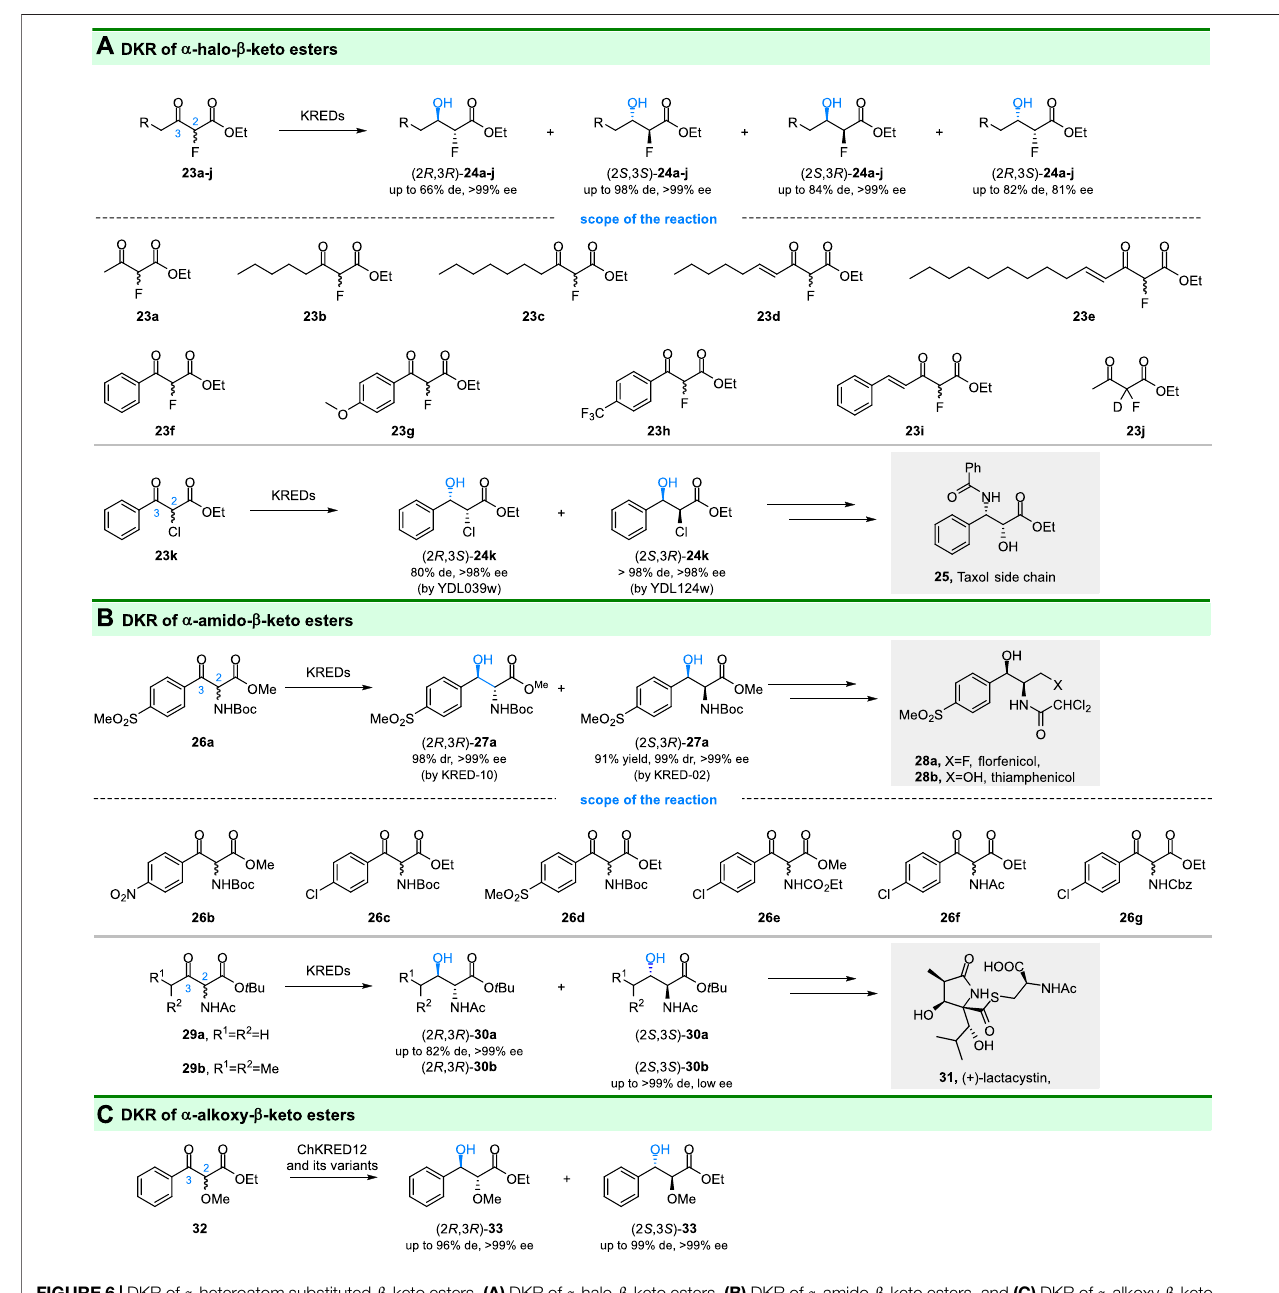
FIGURE 6 | DKR of α -heteroatom substituted- β -keto esters. (A) DKR of α -halo- β -keto esters, (B) DKR of α -amido- β -keto esters, and (C) DKR of α -alkoxy- β -keto esters.